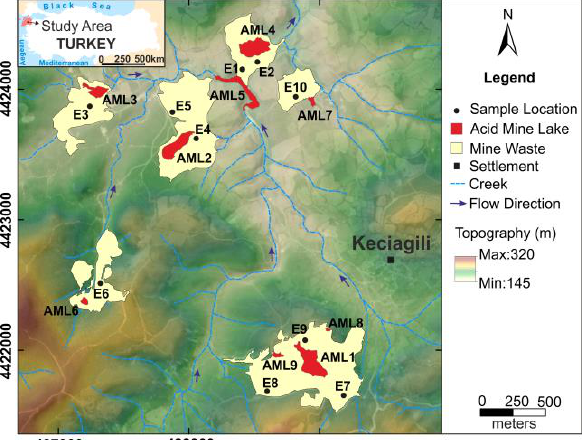
Figure 1. Location map of the study area and sampling